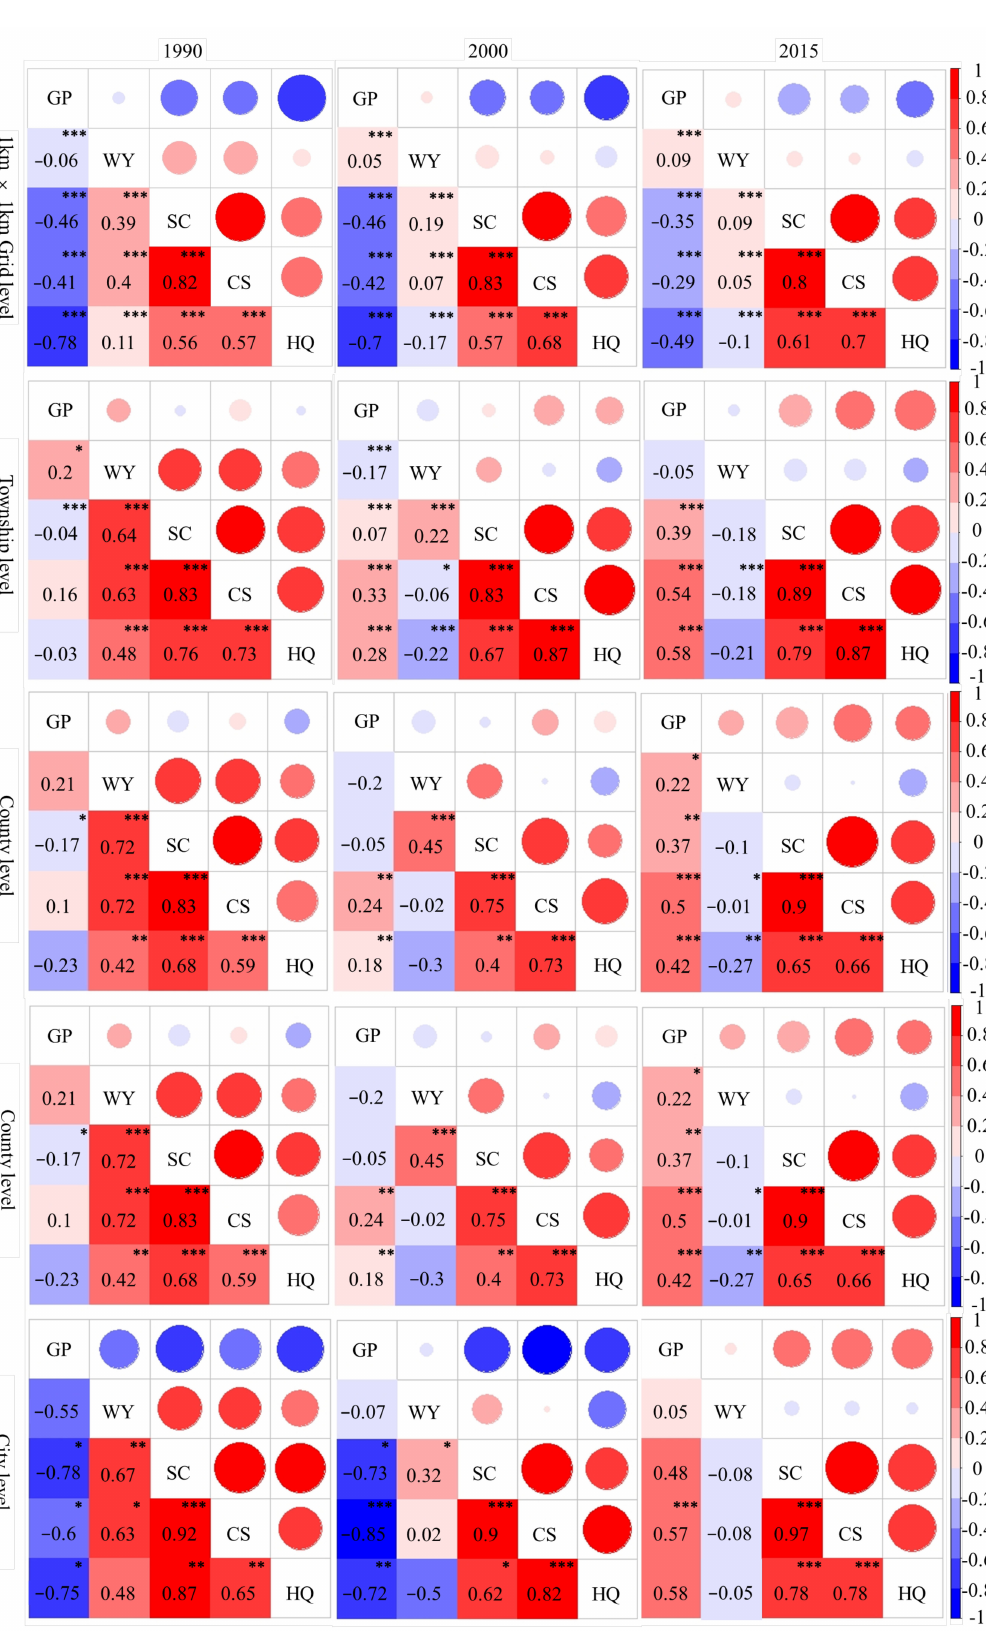
Figure 3. The annual trade-offs/synergies among ecosystem services across spatial scales in the Pearl River Delta from 1990 to 2015. Note: *, **, and *** denote significance at 0.1, 0.05, and 0.01 probability levels,